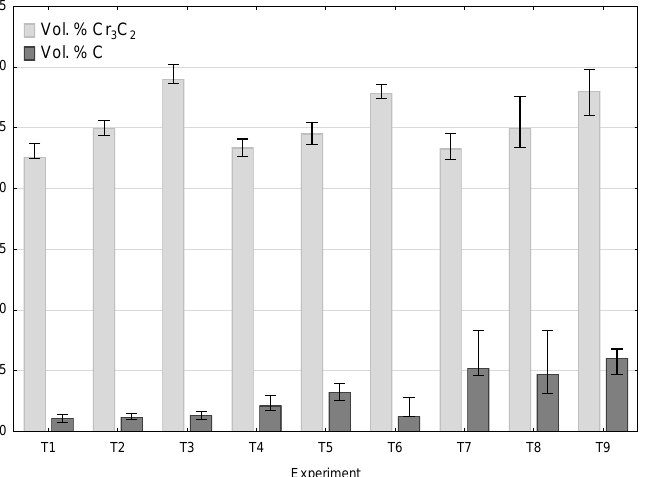
Figure 11. Chromium carbide and graphite volume content in Cr 3 C 2 -25(Ni20Cr)/Ni-25Graphite coatings deposited with the parameter sets from 1 to 9.